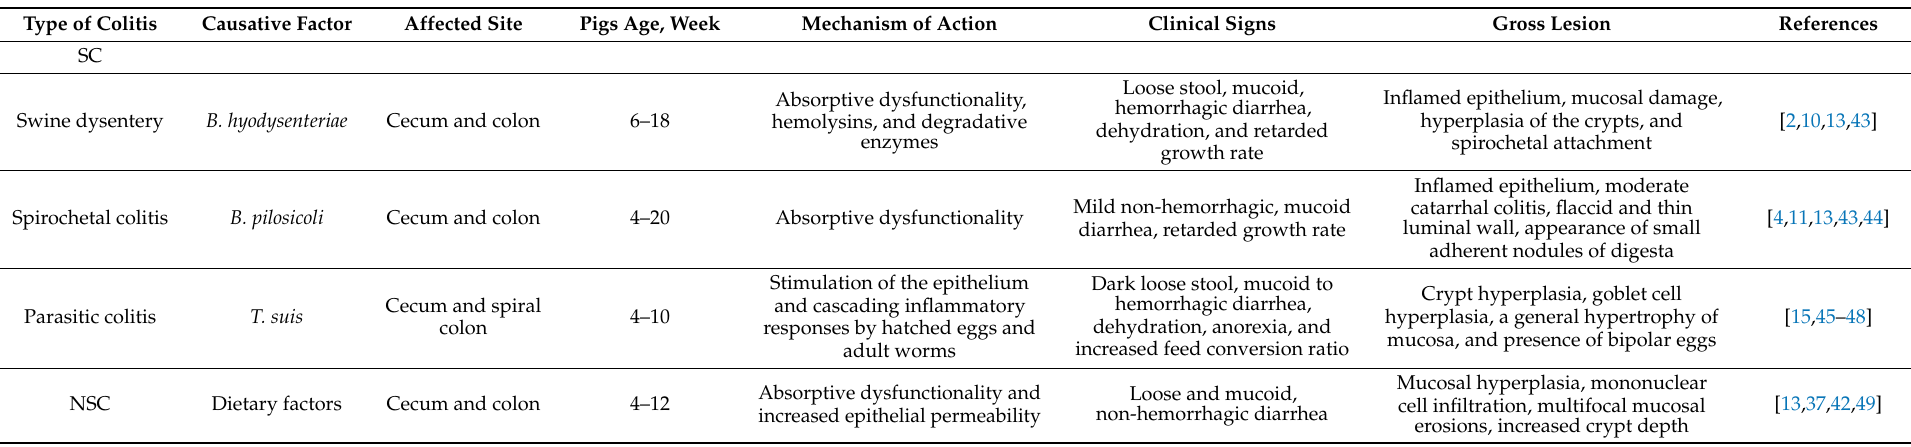
Table 1. Etiology and epidemiology of CCD in growing pigs according to the causative factors and mechanisms of